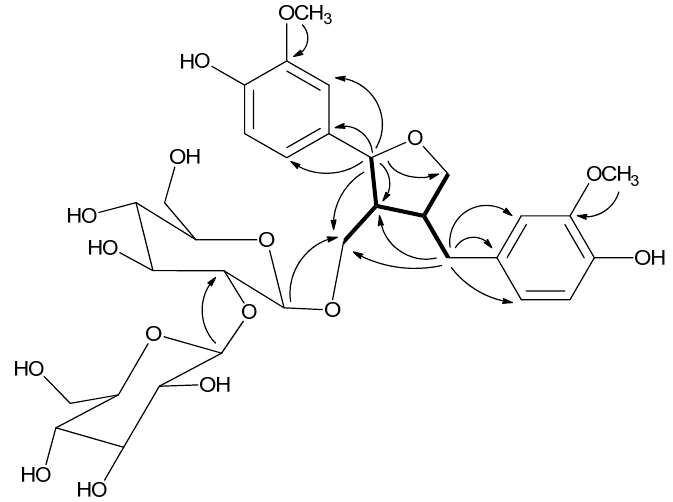
Figure 2. Key 1 H- 1 H COSY (bold dash) and HMBC (arrow) correlations of 1